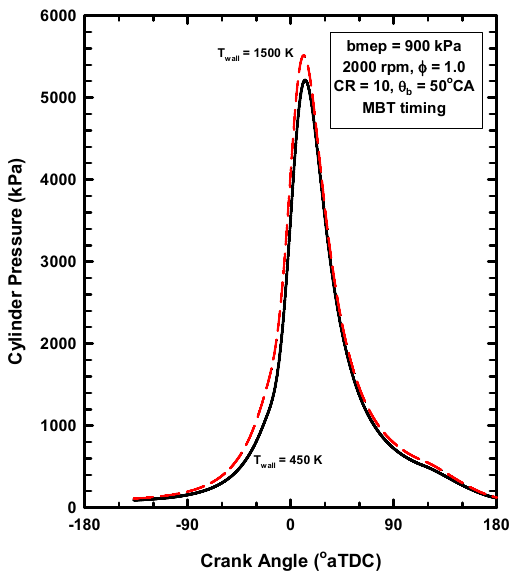
Figure 6. Cylinder pressures as functions of crank angle with cylinder wall temperatures of 450 and 1500 K.